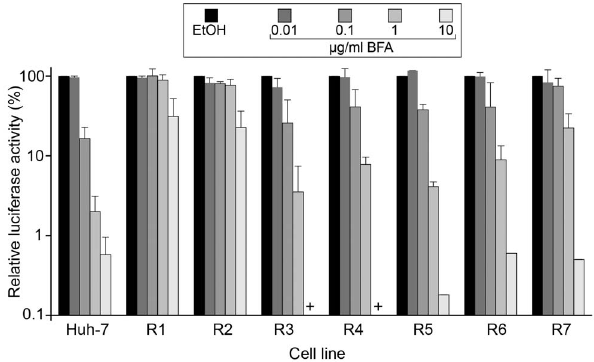
Figure 2. HCV infection in BFA-resistant cells. Cells of the indicated cell lines were infected for 2 h with HCVcc expressing a Renilla luciferase in the presence of the indicated concentrations of BFA. The virus was removed and the cells were left in the presence of BFA for another 6-h period. Cells were lysed in Renilla lysis buffer at 24 hpi, and the luciferase activity was quantified as a measure of HCV infection. Results were expressed as percentages of the values obtained with no BFA. Error bars represent the SD of 3 experiments performed in triplicates. + , values below 0.1%.